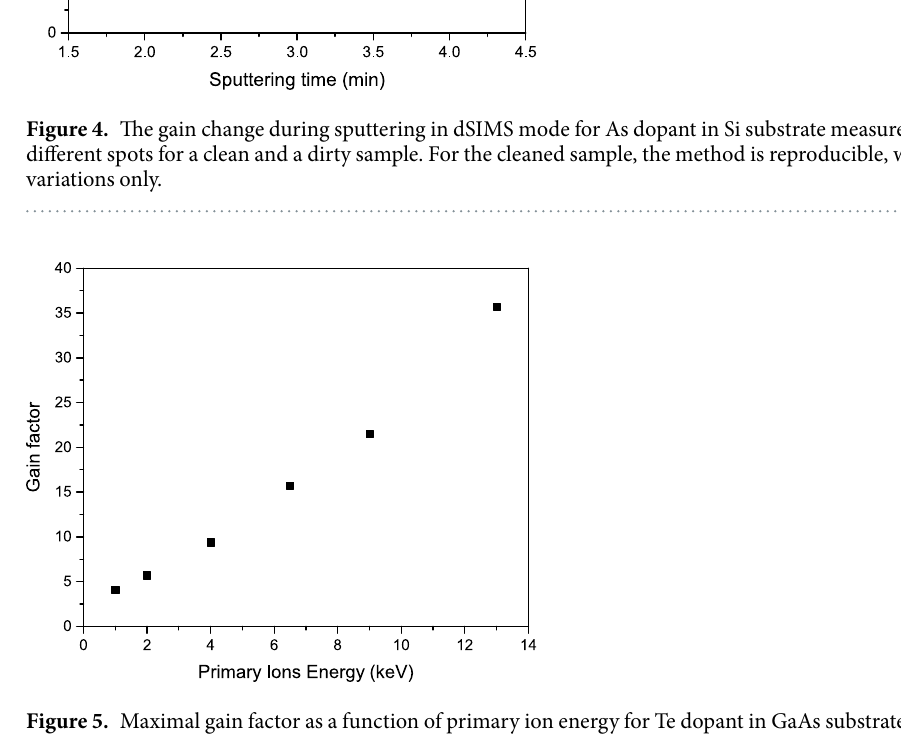
Figure 5. Maximal gain factor as a function of primary ion energy for Te dopant in GaAs substrate. For high- energy ions, a bigger collision cascade is generated and thus it is easier to overcome the graphene blocking